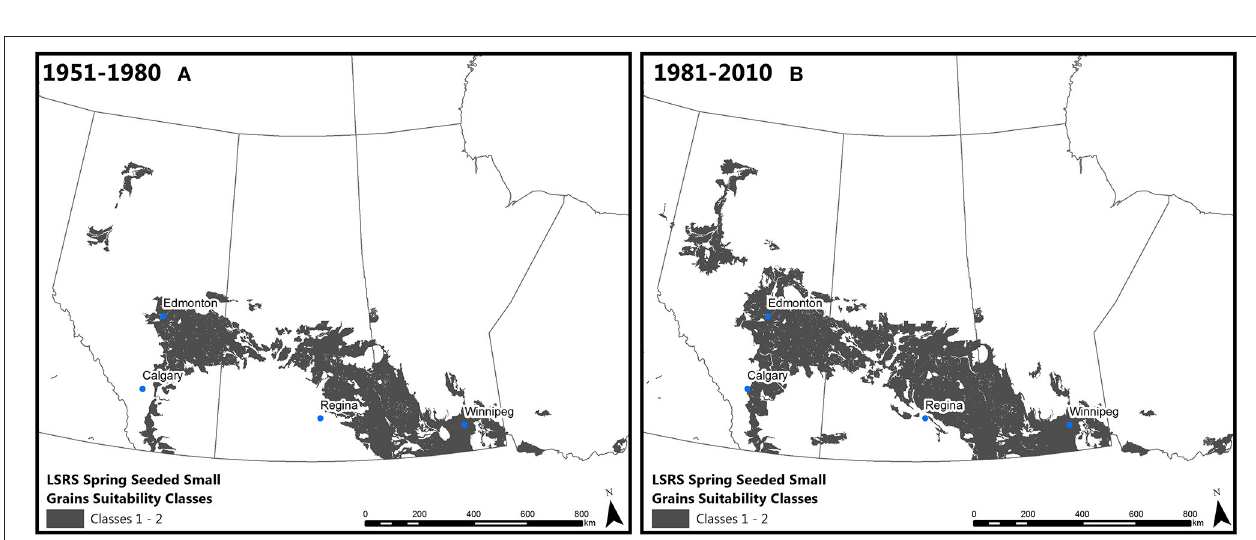
FIGURE 6 | Shaded areas show the expansion of prime land (class 1 and 2) for spring seeded small grains based on the climate normal period 1951–1980 (A) and 1981-2010 (B)